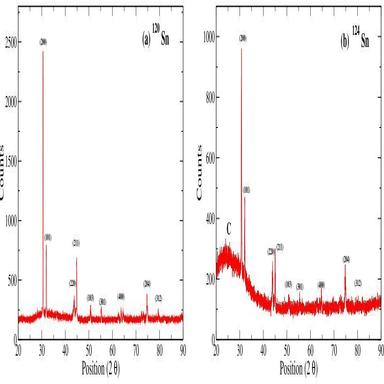
XRD characterization of enriched target films (a) 120Sn, (b) 124Sn to determine the atomic composition of the films.